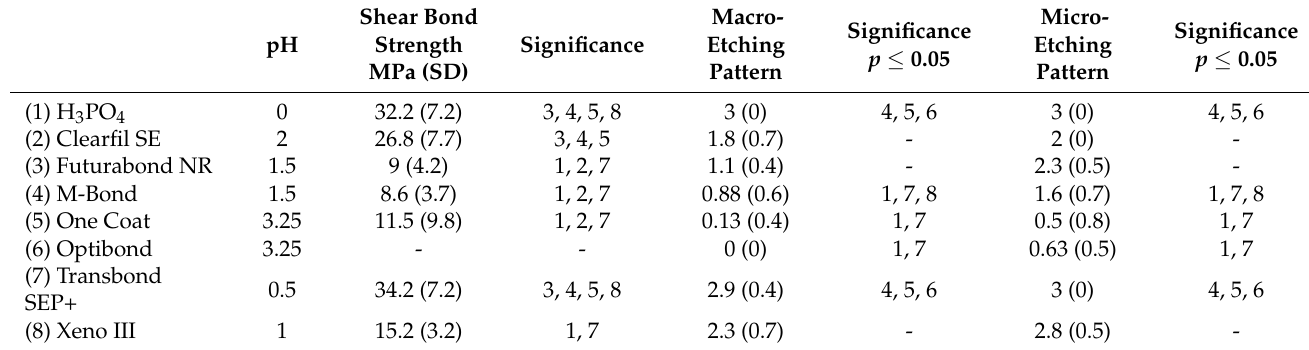
Table 1. pH, shear bond strength, macro-/micro-etching patterns, and standard deviations. Significant differences between different products ( p ≤ 0.05) are indicated by the group